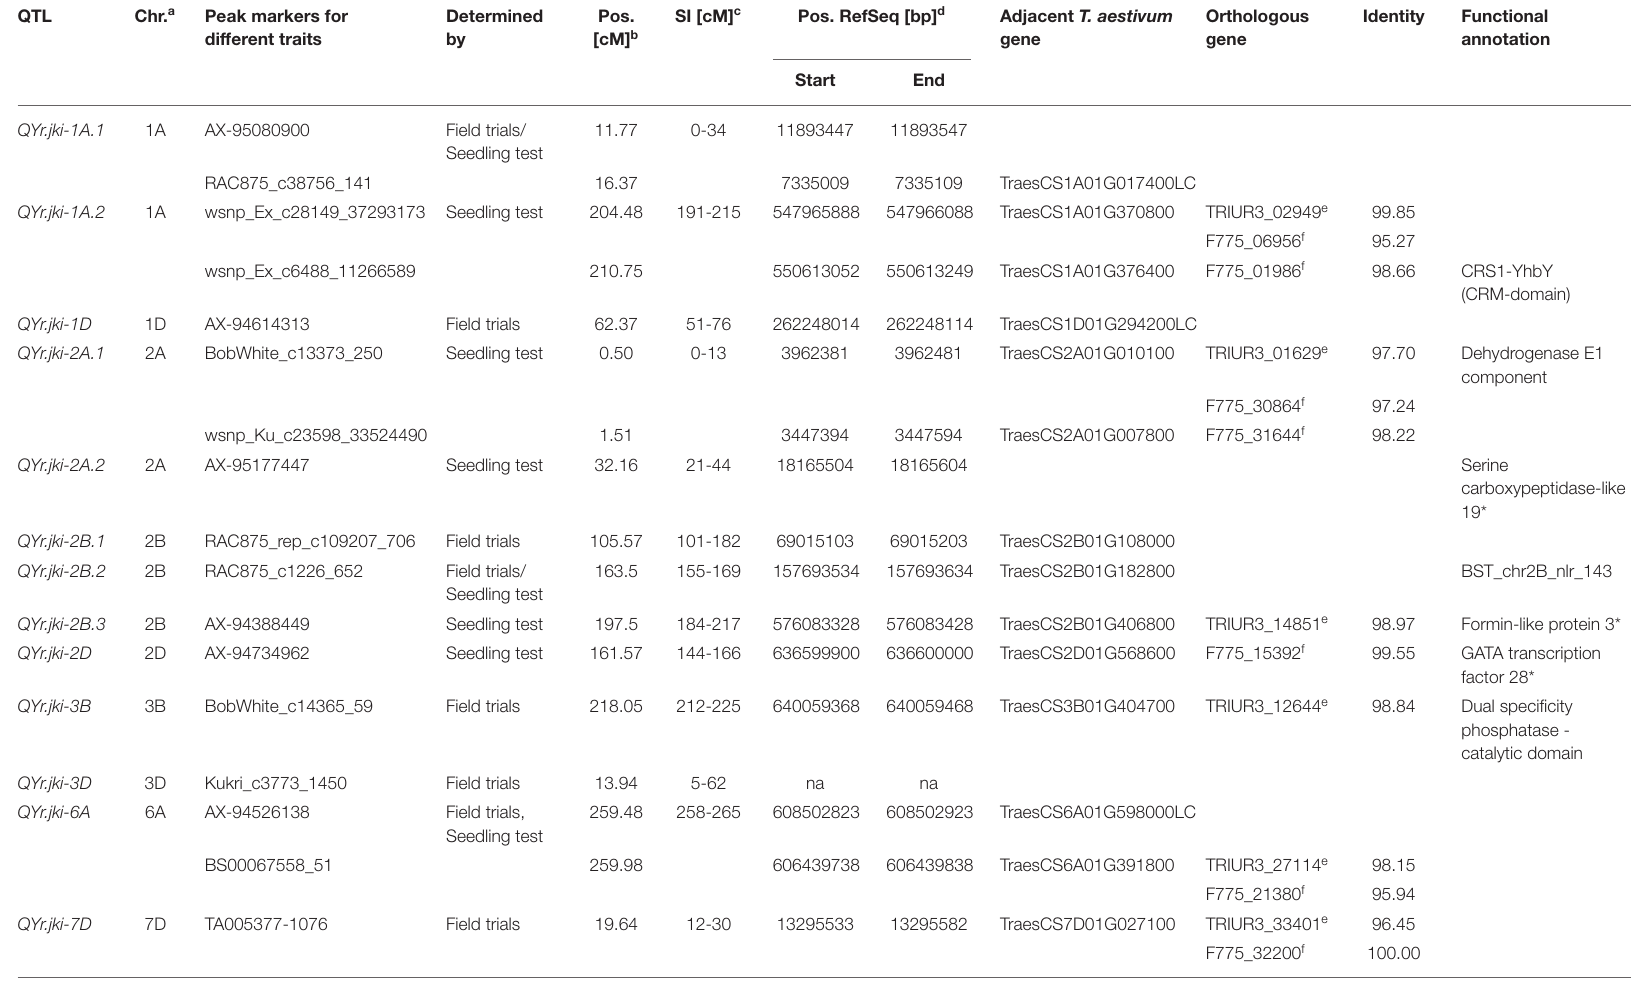
TABLE 4 | Quantitative trait loci (QTL) resistance to Puccinia striiformis merged over all evaluated